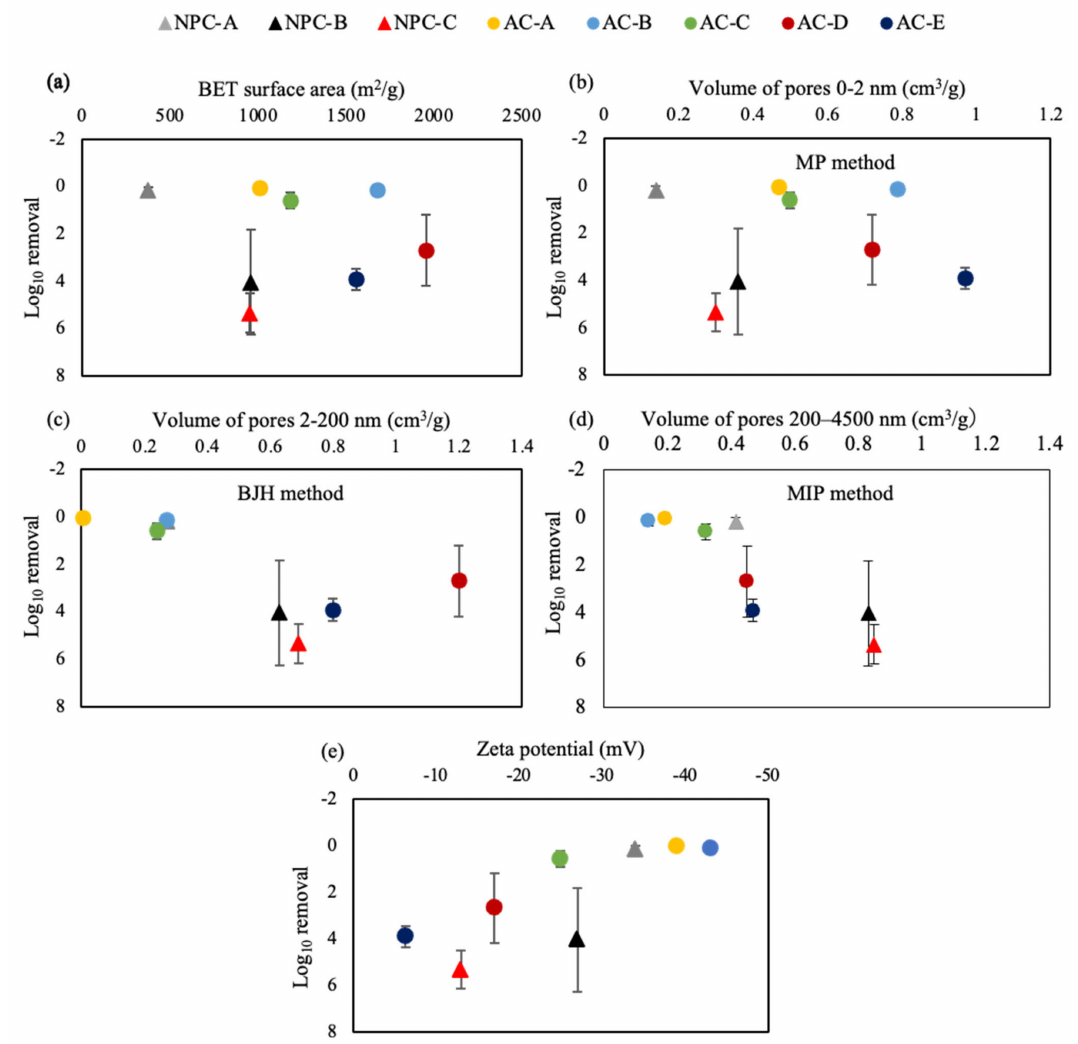
Figure 3. Removal of MS2 by NPCs ( a ) and ACs ( b ) at different contact times (0, 20, 40, and 60 min). Error bars indicate the standard deviation (n = 3).